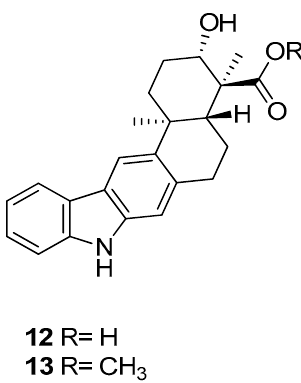
Figure 4. Structures of xiamycin ( 12 ), and its methyl ester ( 13 ).